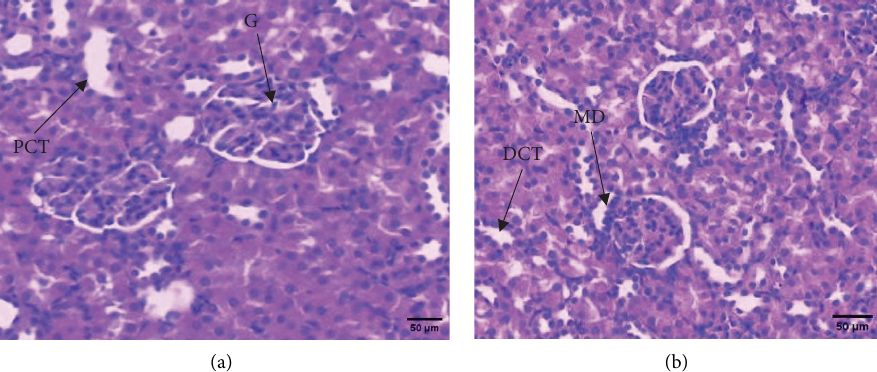
Figure 3: Photomicrograph showing normal rat kidney, section (a) taken from rats in group III (1000mg/kg), section (b) taken from rats in group IV (control); G glomerulus, PCT: proximal convoluted tubule, DCT: distal convoluted tubule, MD: macula densa cells; H and E stain, and 200x